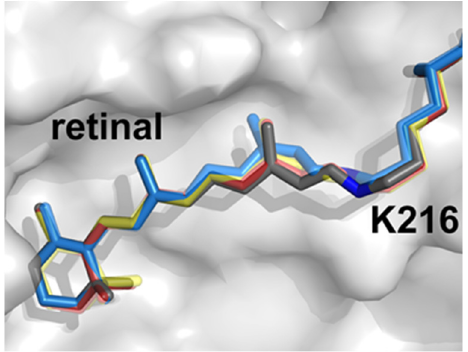
Figure 3. bR retinal trans -to- cis isomerization observed by ultrafast TR-SFX. Dark grey indicates the dark state, red and orange intermediates (49–406 and 457–646 fs), and blue the 13- cis isomer (10 ps) prior to relaxation. Illustration derived from PDB 6G7H, 6G7I, 6G7J, 6G7K.